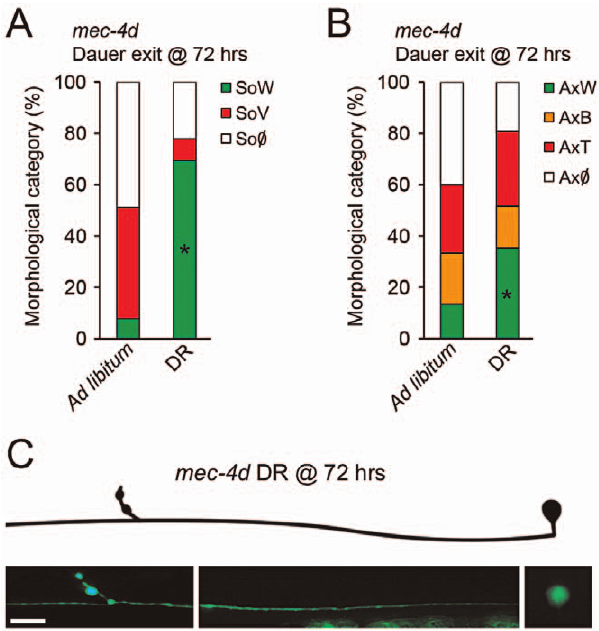
Figure 6. Dietary restriction inhibits mec-4d –dependent neuro- nal degeneration in C. elegans . (A–B) The influence of dietary restriction (DR) in TRN degeneration was investigated by fasting mec-4d worms intermittently with a protocol consisting of 3 hours of ad libitum food regime followed by 9 hours of starvation. After 72 hours, the worms on DR show a significant protection of both AVM somas (A) and axons (B) compared to the 72 hours ad libitum fed worms (mean value for each category is shown; error bars [ , 1%] not included; N=3 of 30 worms each per group; *p , 0.005 by Student’s t test compared with control for the SoW and AxW category). (C) AVM neuron with a morphologically conserved soma and axon from a mec-4d worm subjected to DR for 72 hours by means of intermittent fasting. Scale bar, 10 m m.